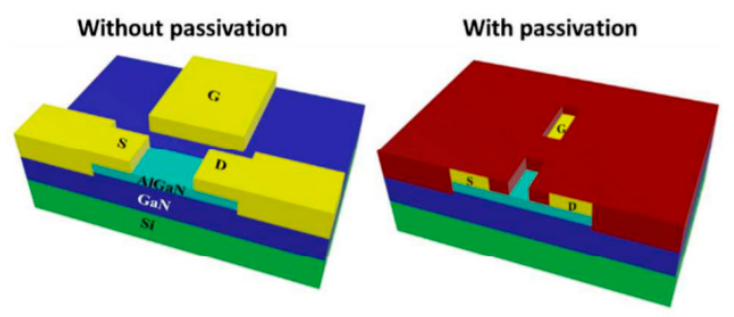
Figure 13. Structure of the electrical double layer FET (EDLFET), using AlGaN as a semiconductor, with and without the passivation layer (to better see the structure). Adapted from Pulikkathodi et al. [76], with permission of The Royal Society of Chemistry.